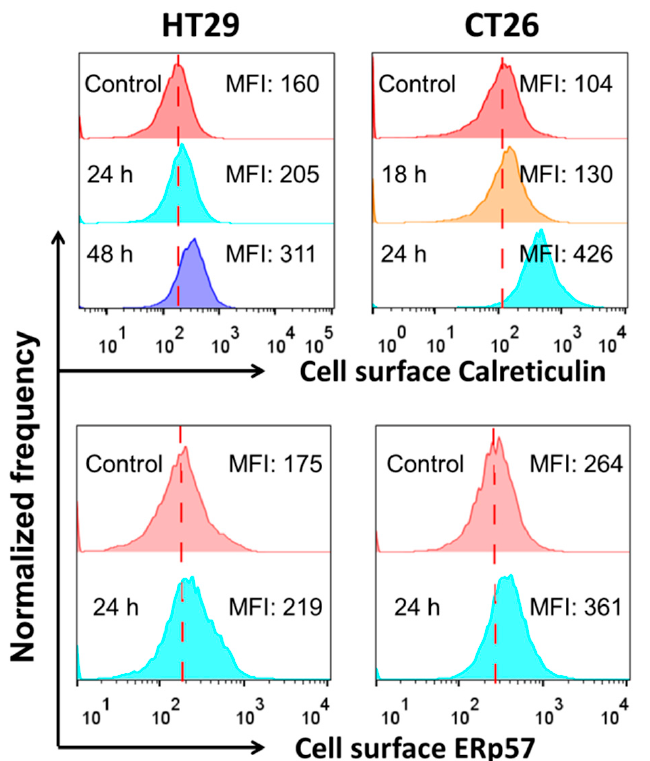
Figure 5. Exposure of calreticulin and ERp57 in HT29 or CT26 cells treated with SeNps. Cells were treated with SeNps (15 µ g/mL) for 24 h and analysed by flow cytometry for the quantification of surface fluorescence signal, after being labelled with either an anti-calreticulin or anti-ERp57 primary antibody and a Alexa fluor-488 conjugated secondary antibody. Only live cells (7-AAD negative) were analysed; dead cells or cells with compromised membranes were excluded from the analysis by 7-AAD staining. A significant increase in the calreticulin and ERp57 exposure, evident by the elevated MFI values, was observed in both the CT26 and HT29 cells after SeNps treatment. Data were analysed with FlowJo v.10. Results are representative of at least three independent experiments. Fluorescence intensity